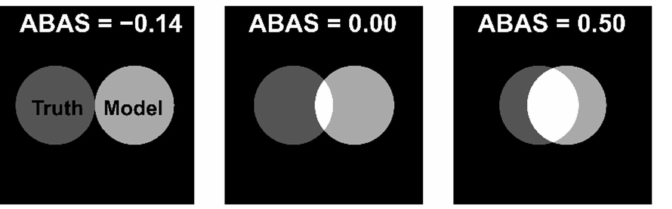
Figure 5. Examples of ABAS results in different cases of agreement between ground truth and